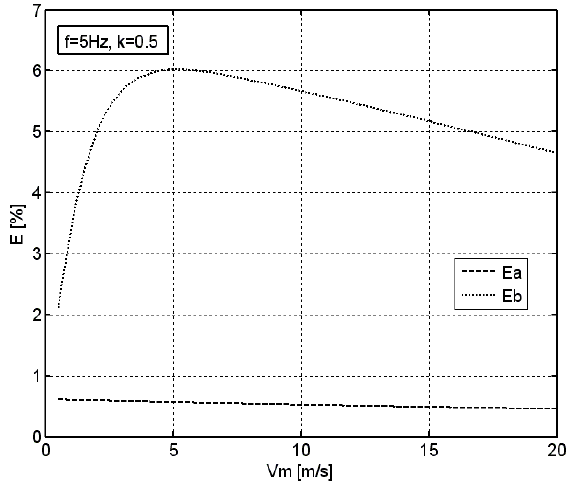
Figure 7. The effect of average velocity of sinusoidal excitation v m on the relative error of its measurement E for both measuring systems, k = 0.5, f = 5 Hz.